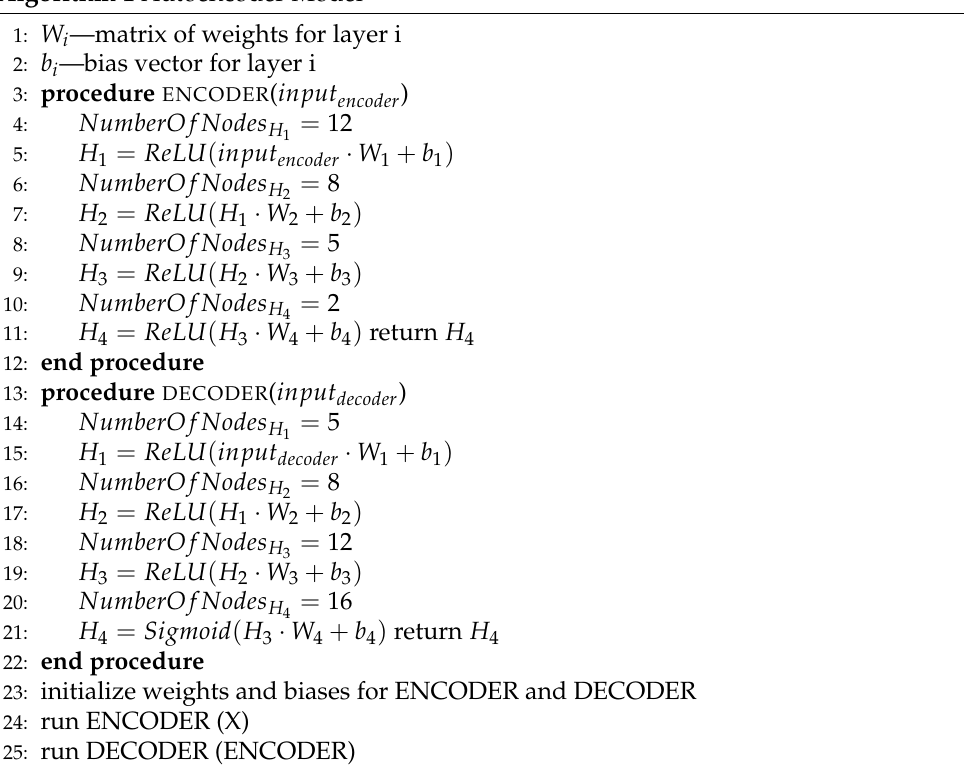
Algorithm 1 Autoencoder